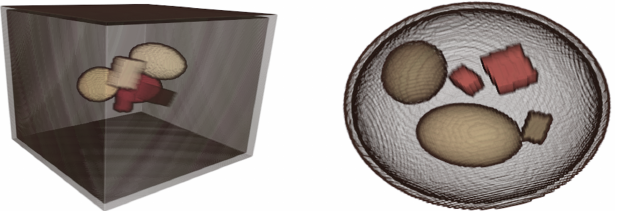
Figure 2. Two 3D representations of the randomly generated phantoms. A cuboid ( left ) and an ellipsoid ( right ) envelope, containing objects with randomly chosen shape, size, center coordinates and material